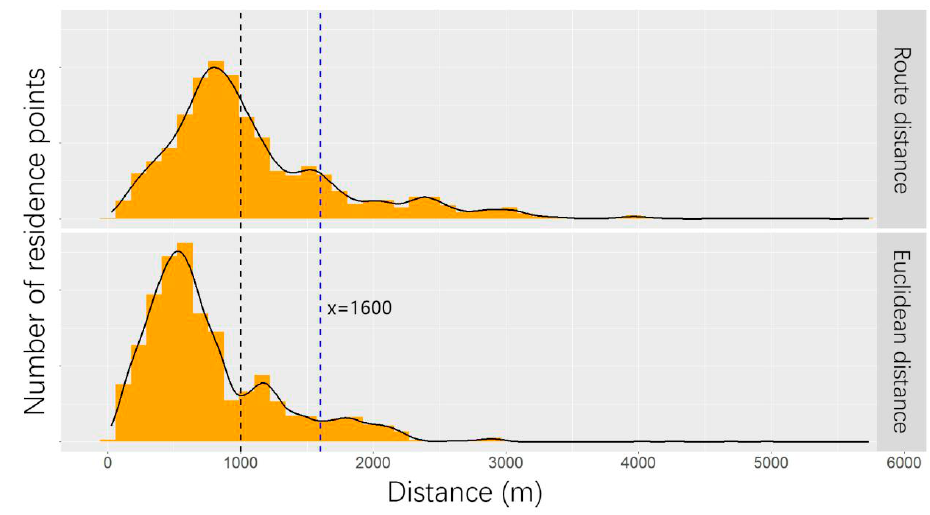
Figure 3. Number of residence points in two kinds of distances for middle schools.